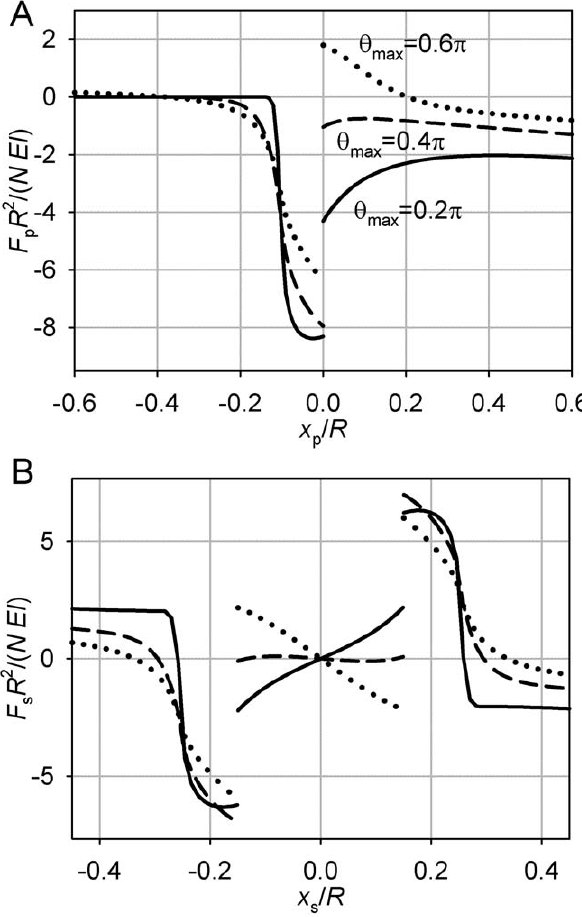
Figure 5. Transition between h max =0 and h max = p in the case of short astral microtubules. L =0.8 R . (A) Pole force function. (B) Spindle force function, h max = p /5.